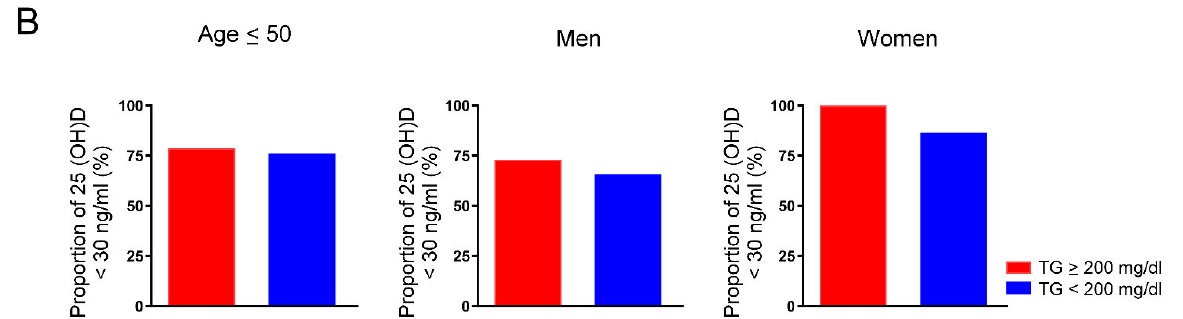
Figure 3. Proportion of vitamin D deficiency in people aged between 50 and 65 years or younger than 50 years with and without hypertriglyceridemia. The rate of serum 25-hydroxyvitamin D (25(OH)D) levels below 30 ng/mL of individuals in total, men, and women aged between 50 and 65 years ( A ) and younger than 50 years ( B ) whose serum levels of triglycerides (TG) were greater or less than 200 mg/dL. * p < 0.05.